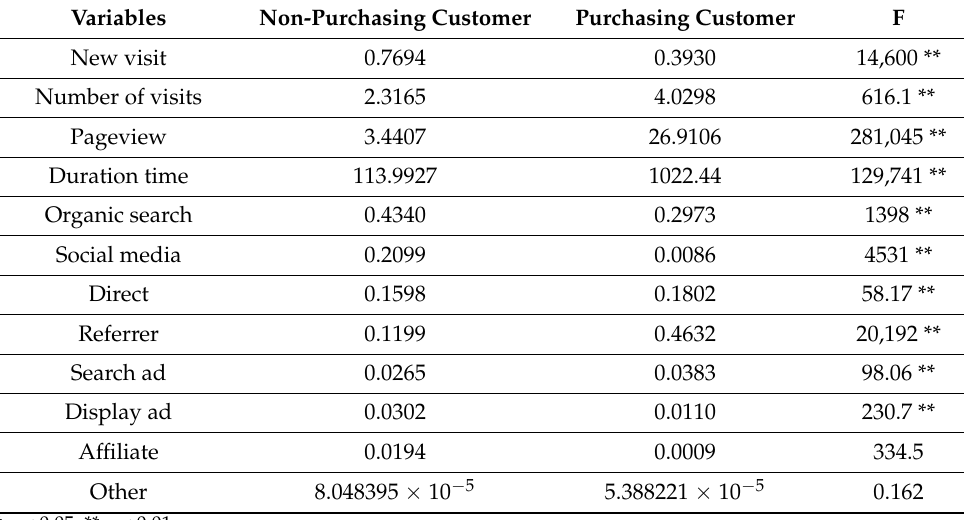
Table 3. Comparison of consumer session data with or without conversion.